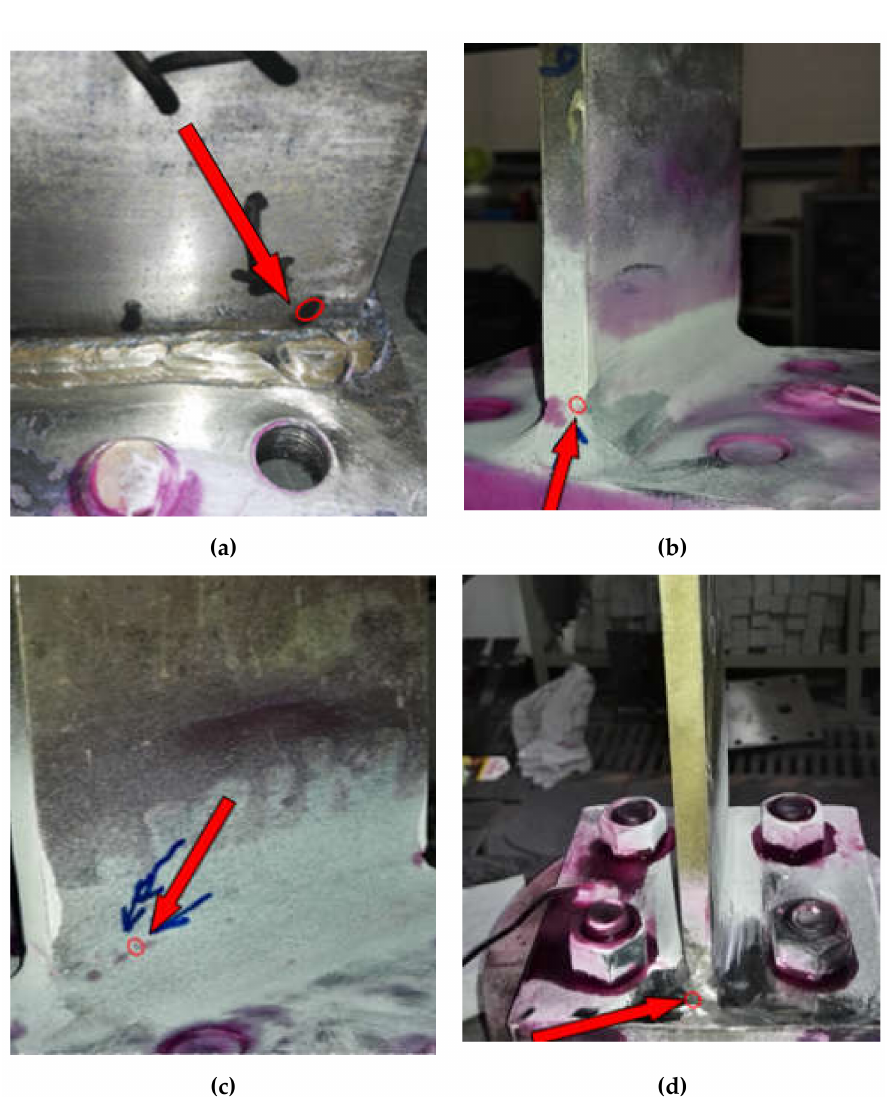
Figure 6. Cracks locations on T-type welded metallic plate ( a ) at upper welding toe ( b ) near the edge corner ( c ) on the weld toe ( d ) near side edge